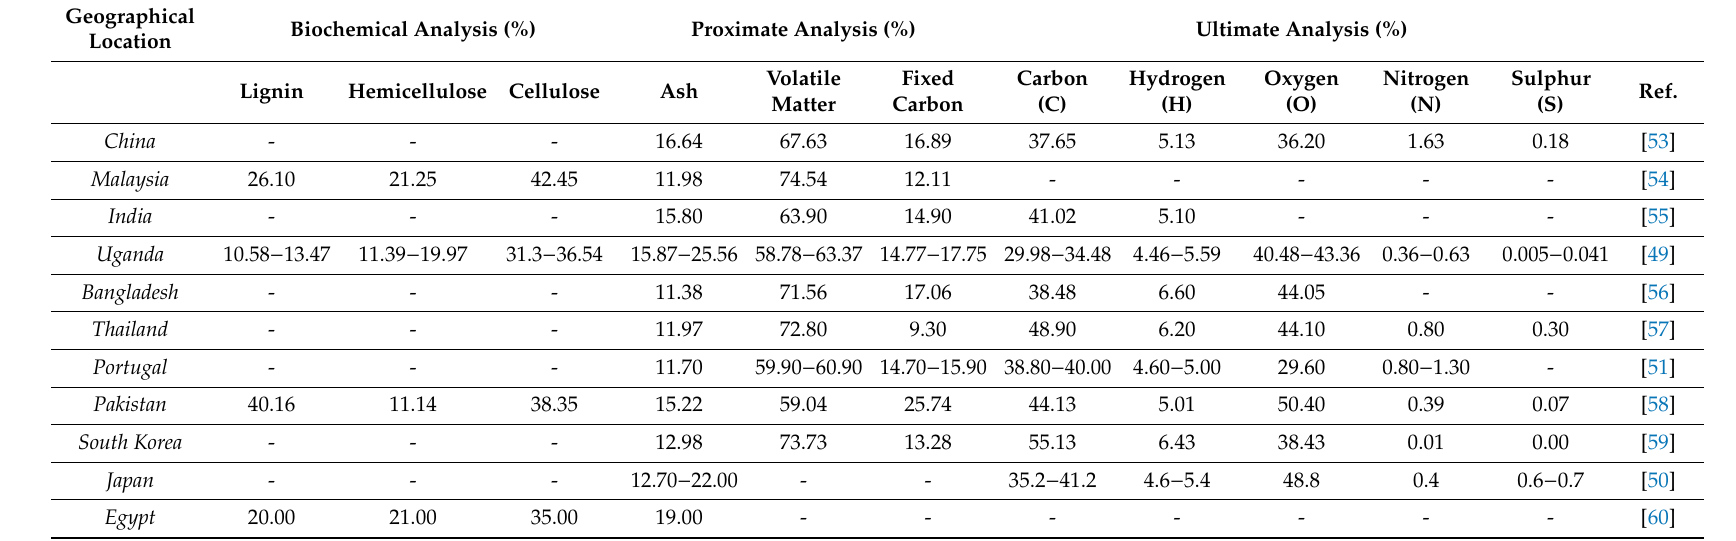
Table 2. Chemical composition of rice husk (RH) ash (total 100% in each column).